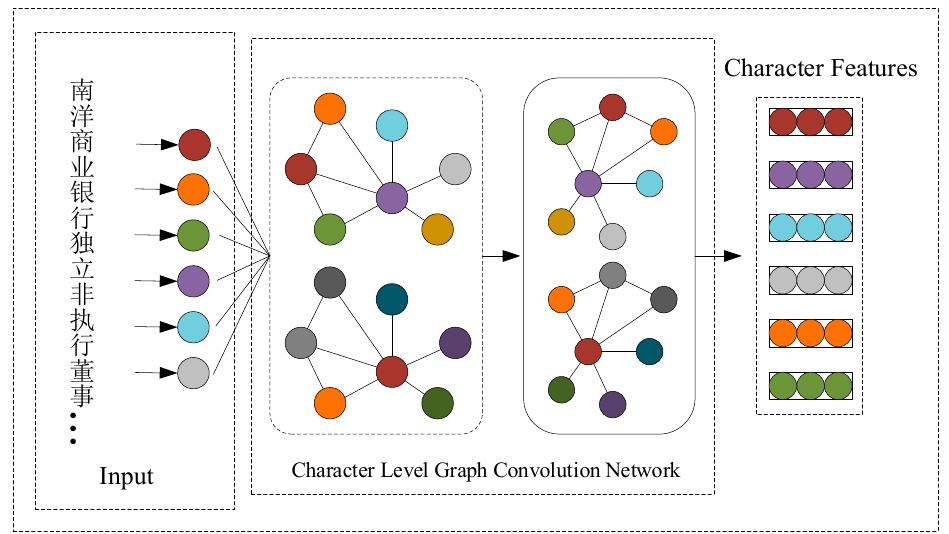
Figure 1. Network structure of the character-level graph convolution network.